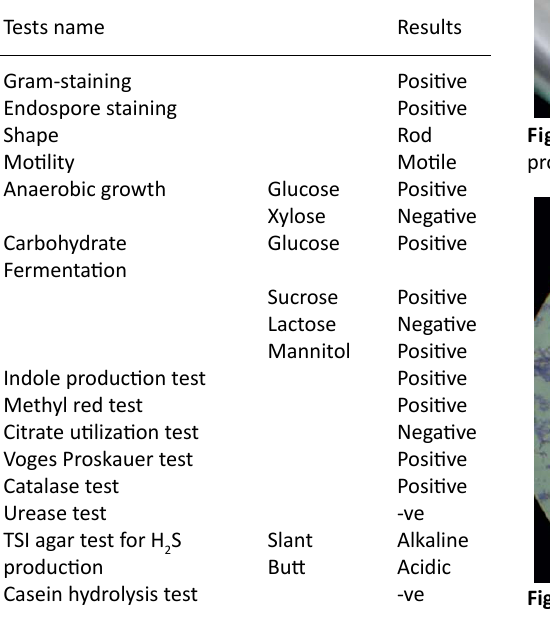
table 1. Results of various tests performed to identify the